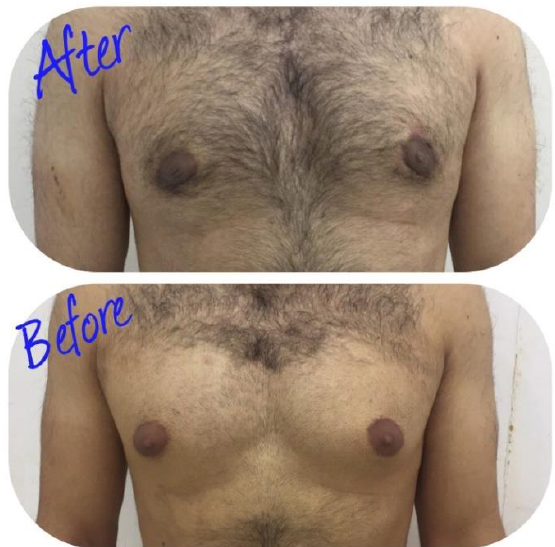
Figures (b) Lateral views with Simon 3 befor and after